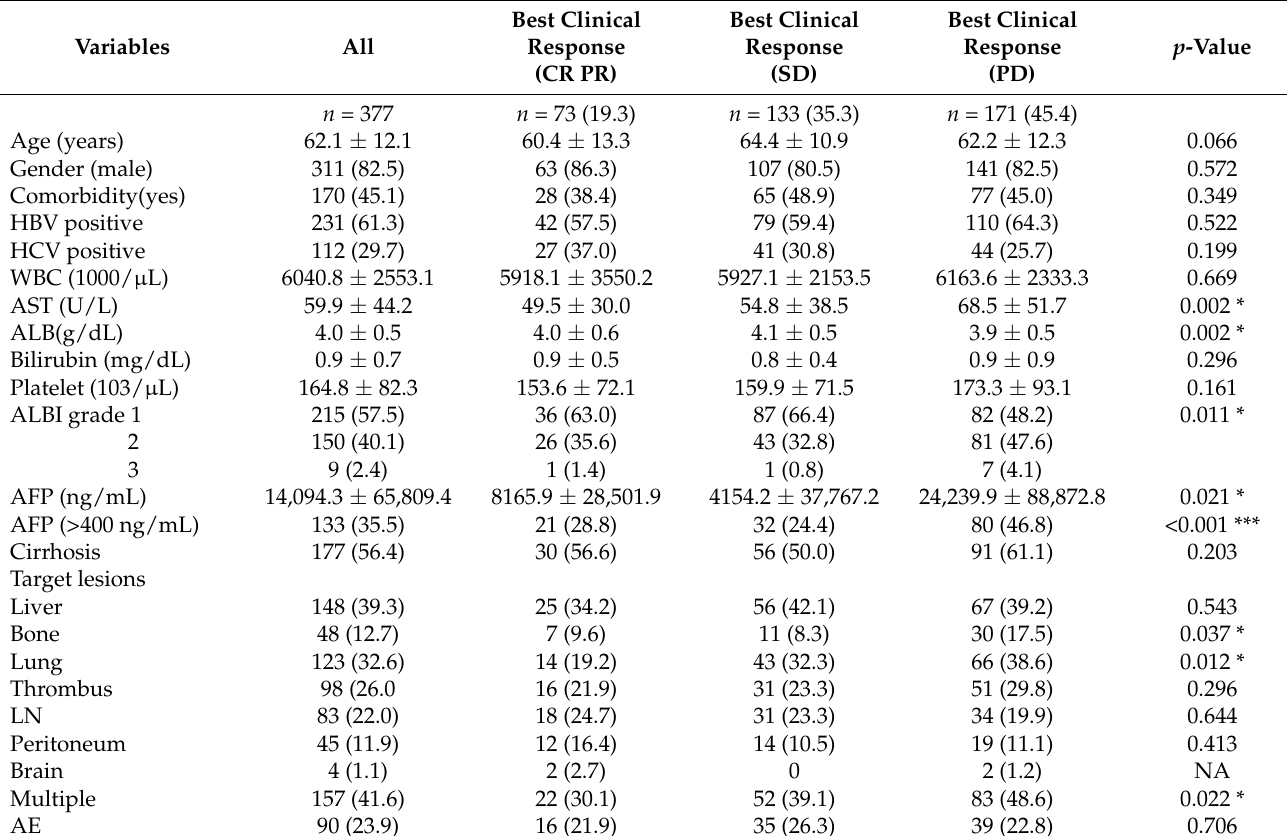
Table 1. Demographic data of advanced HCC patients receiving sorafenib, and correlation with clinical responses.